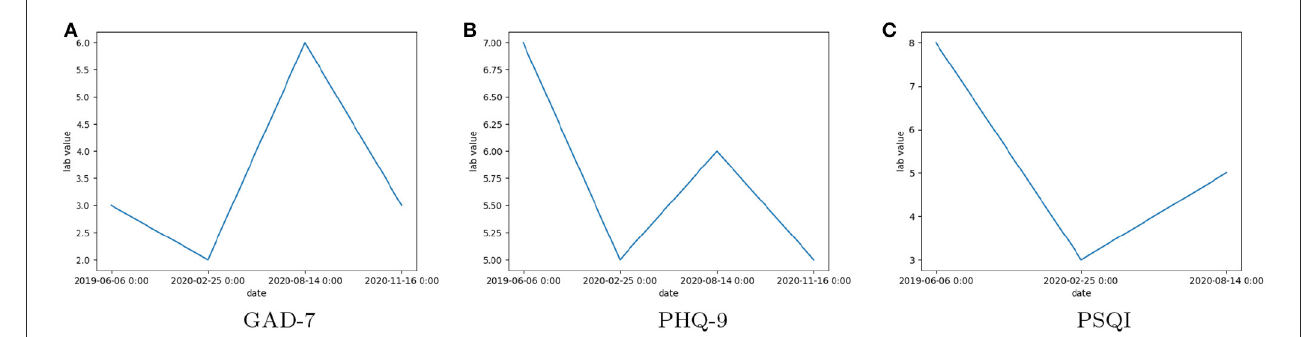
FIGURE2 The observed scores of Clinical Assessment Tool Values: (A) General Anxiety Disorder 7 (GAD-7), (B) Patient Health Questionnaire 9 (PHQ-9), (C) Pittsburgh Sleep Quality Index (PSQI), for a single patient over multiple visits between June 2019 and November 2020.